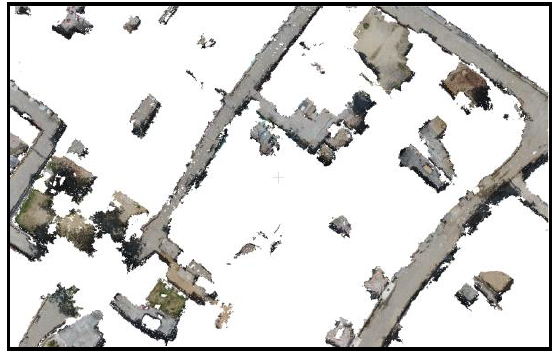
Figure 4: Ground points